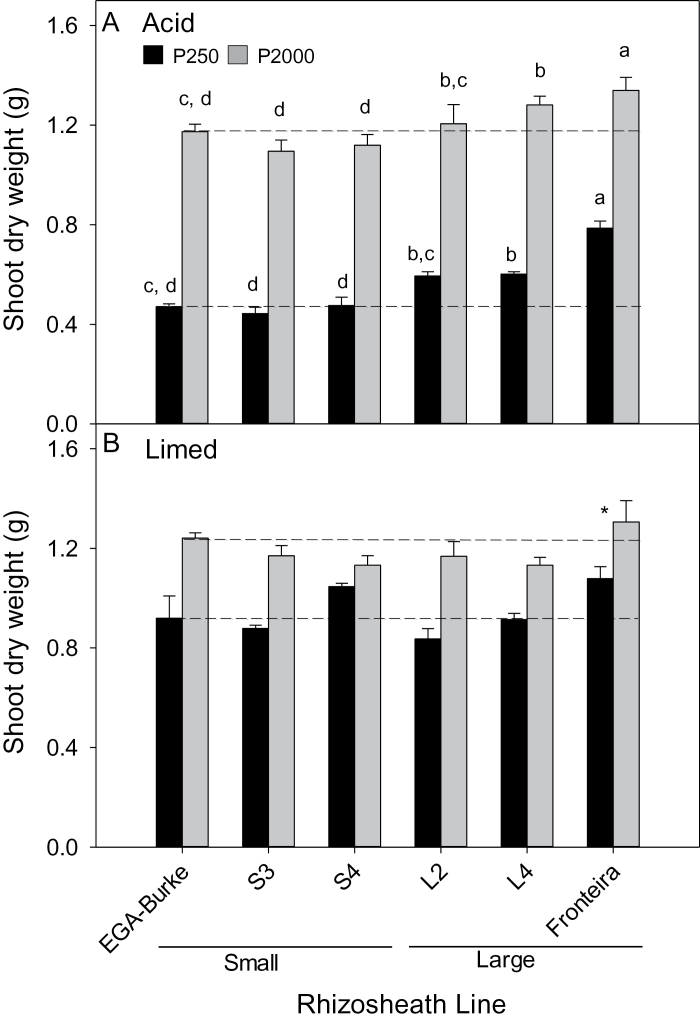
Shoot biomass of EGA Burke, Fronteira and BC3 NILS with large (L2, L4) or small (S3, S4) rhizosheaths grown in (A) a non-limed (pH 4.3) and (B) a limed (pH 5.5) ferrosol with 250mg kg–1 or 2000mg kg–1 added P. Values are means (n=4) and different letters indicate significant differences (P<0.05) between genotypes (no interaction between genotypes and treatments). A significant genotype difference (P<0.05) in (B) is indicated by *. For reference, the dashed lines show shoot dry weights of EGA Burke at low (lower lines) and high (upper lines) P treatments.